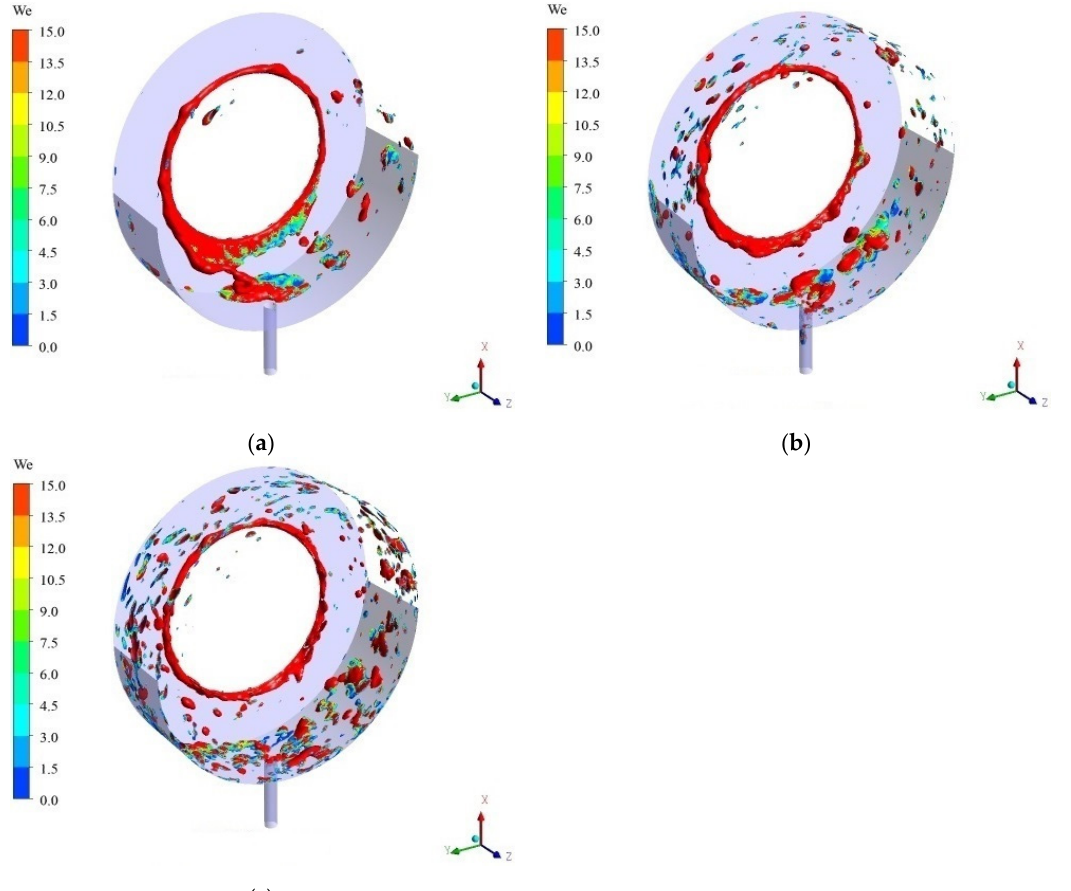
Figure 16. Weber number contour ( α =0.25) at different rotor speeds in steady state: ( a ) n = 5000 rpm; ( b ) n = 10,000 rpm;( c ) n = 15,000 rpm.